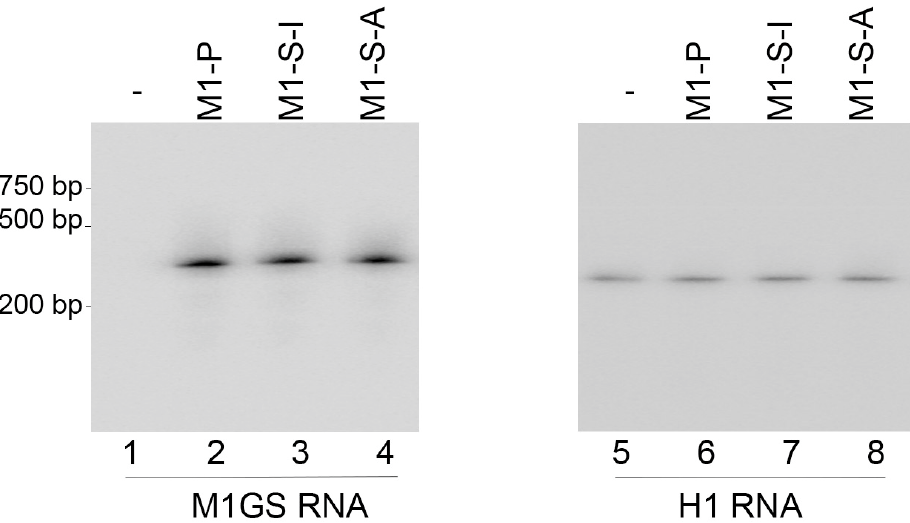
Figure 1. M1GS RNA expression in HepG2.2.15 cells assayed by Northern blot analyses. RNA samples (30 µ g) from cells containing the empty vector pU6 (-, lanes 1 and 5), pU6-M1-P (lanes 2 and 6), pU6-M1-S-I (lanes 3 and 7), and pU6-M1-S-A (lanes 4 and 8), were separated on 2% agarose gels that contained formaldehyde, transferred to nitrocellulose membranes, and hybridized to radio- labeled probes specifically for M1 RNA (lanes 1–4) or H1 RNA (loading control) (lanes 5–8).